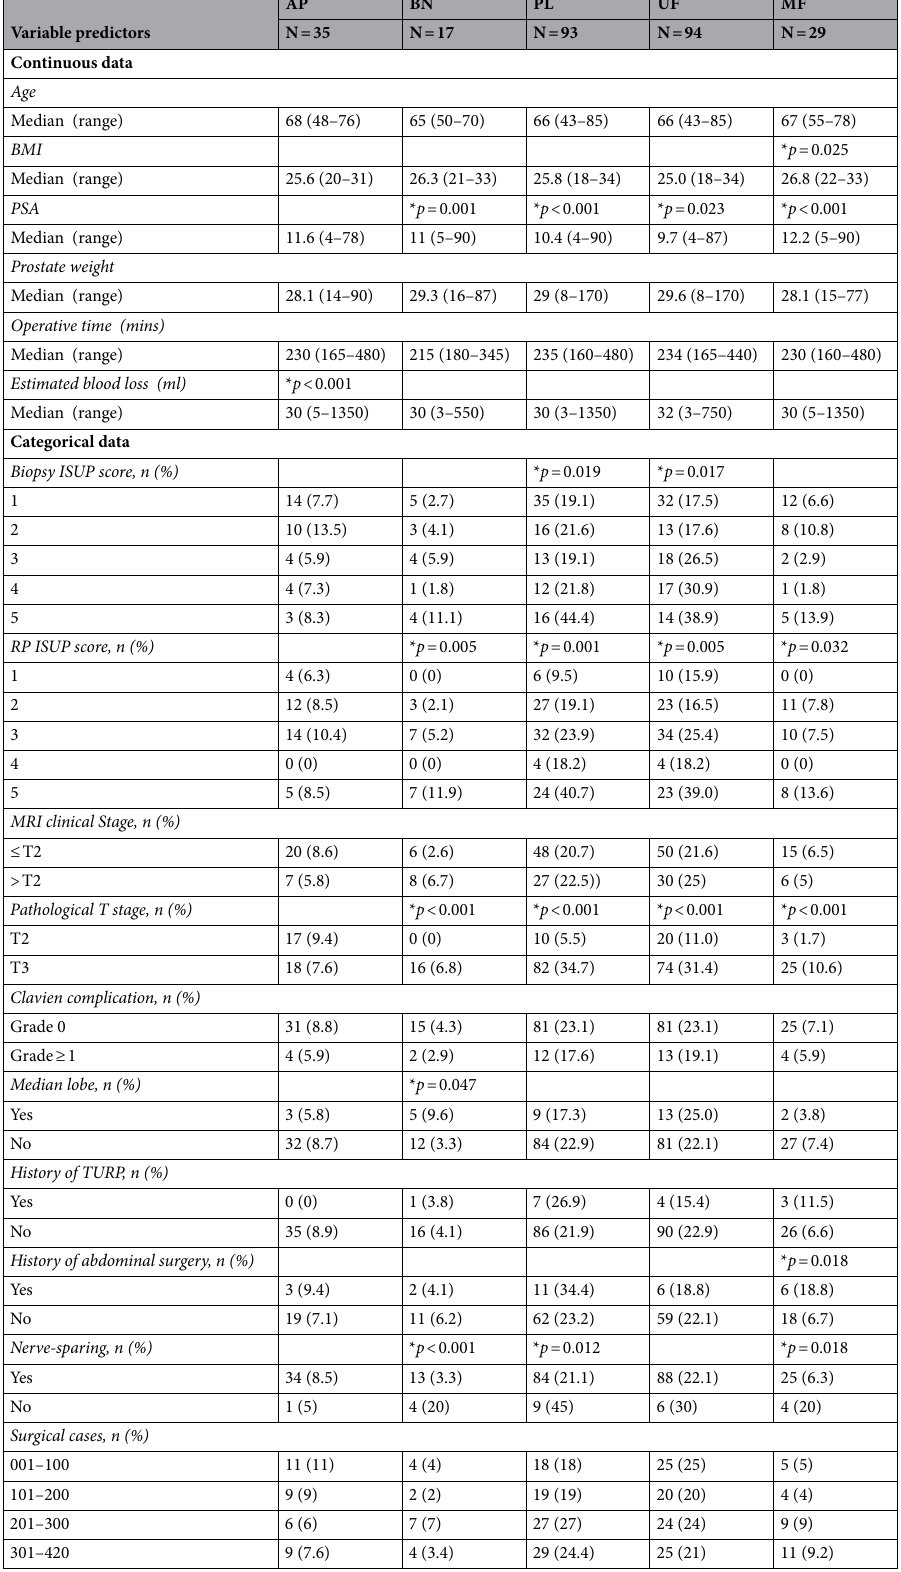
Table 3. Predictors based on the location and number of positive surgical margins. PSA prostate-specific antigen, BMI body mass index, ISUP International Society of Urological Pathology, RP radical prostatectomy, TURP transurethral resection of the prostate, AP apex, BN bladder neck, PL posterolateral, UF unifocal, MF multifocal, * p value for difference between margins status < 0.05; statistical analysis, continuous data: t -test, categorical data: chi-square